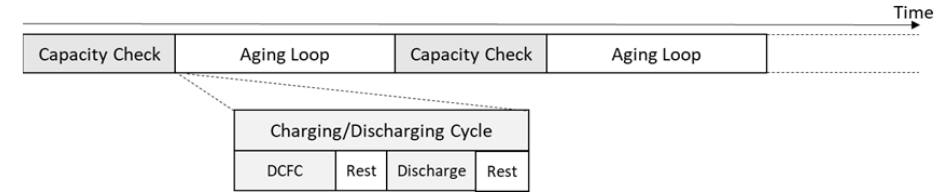
Figure 8. Charge/Discharge aging.